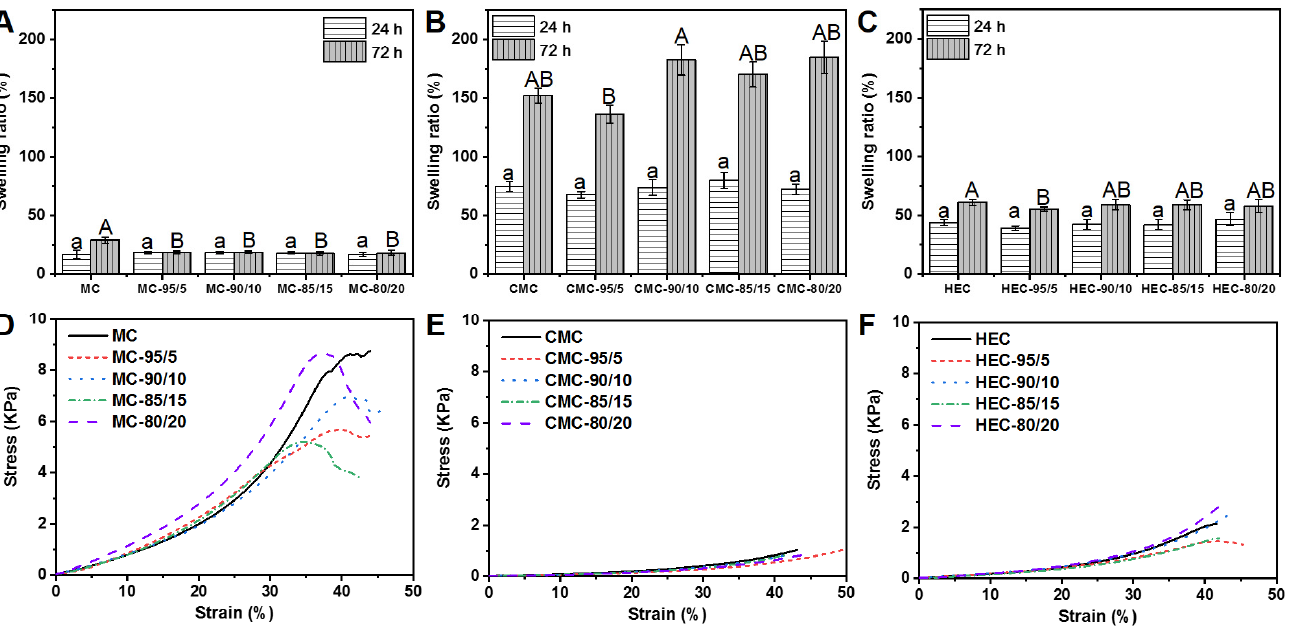
Figure 2. Swelling ratio ( A – C ) and stress-strain curves ( D – F ) of cellulose/WPU composite hydrogels. ( A – C ) Different letters indicate significant differences when using the same cellulose material at the 0.05 level obtained by Tukey’s test and analysis of variance (ANOVA). Different letters indicate significant differences between addition ratios of WPU in the same cellulose material at the 0.05 level obtained by Tukey’s test and analysis of variance (ANOVA). The letters of 24 h and 72 h are marked as “a and b” and “A and B”, respectively.